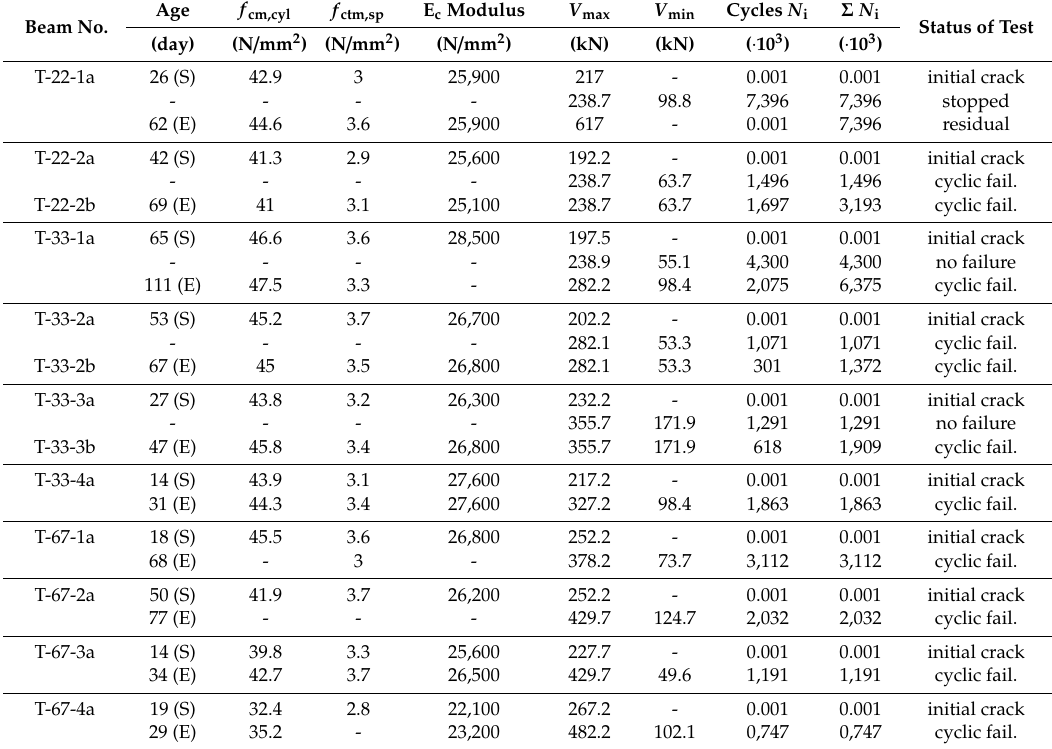
Table 2. Concrete strength (mean values), load combinations, load cycles, and failure types. Beam